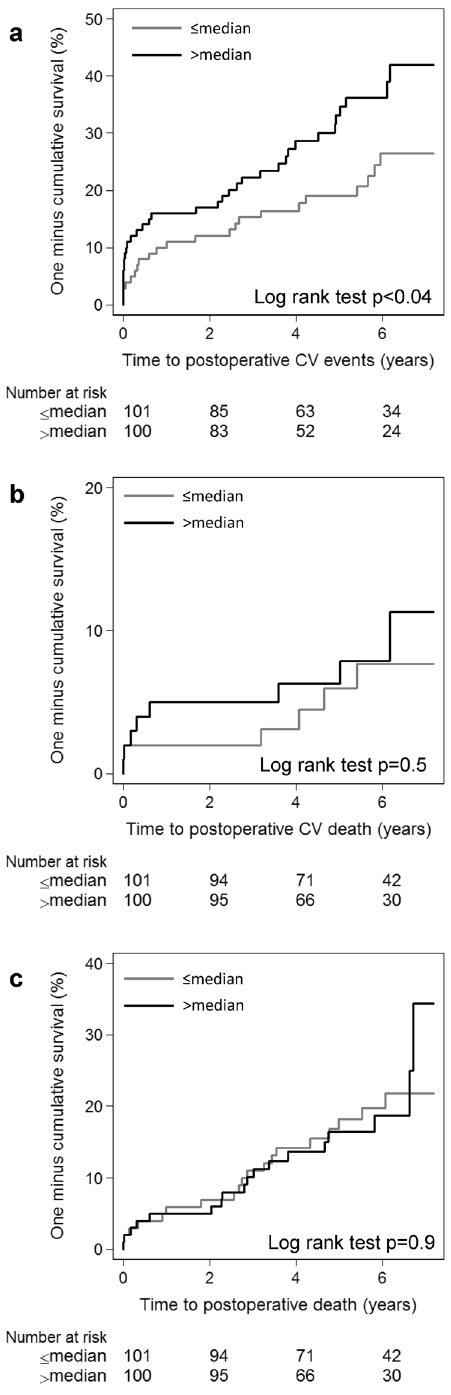
Figure 5. Association between ADAMTS-7 (% of plaque area stained) in lesions and risk of a future CV event. Kaplan-Meier curves illustrating risk for postoperative CV events ( a ), CV deaths ( b ) and all causes deaths ( c ) across ADAMTS-7 above or below the